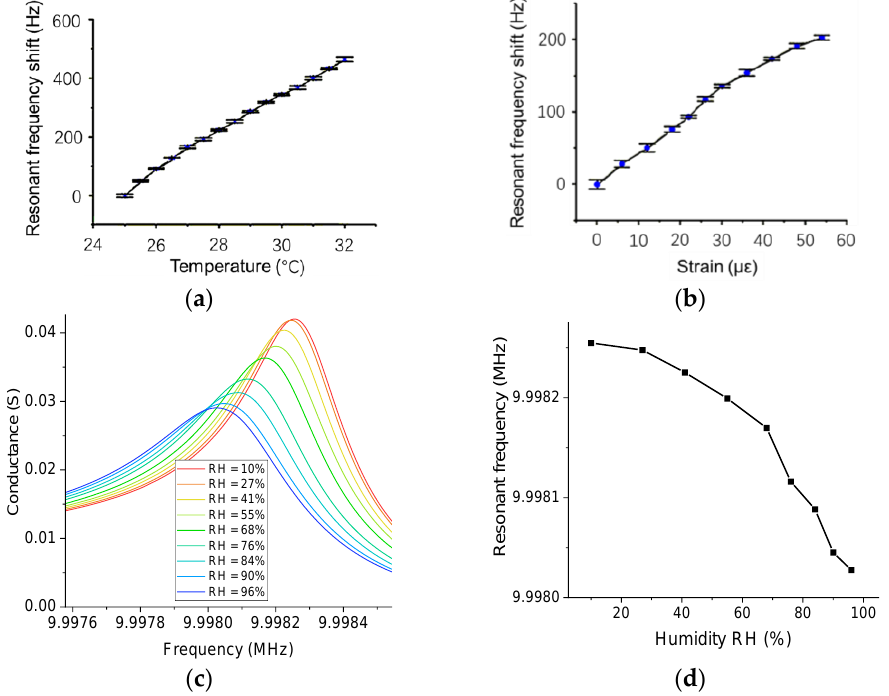
Figure 13. The effect of environmental conditions on a BAW passive wireless strain sensor. ( a ) Temperature vs. resonance shift. ( b ) The calibration of strain with temperature compensation. In ( a , b ), all experiments were repeated five times. ( c ) Humidity vs. conductance. ( d ) Humidity vs. resonance shift.